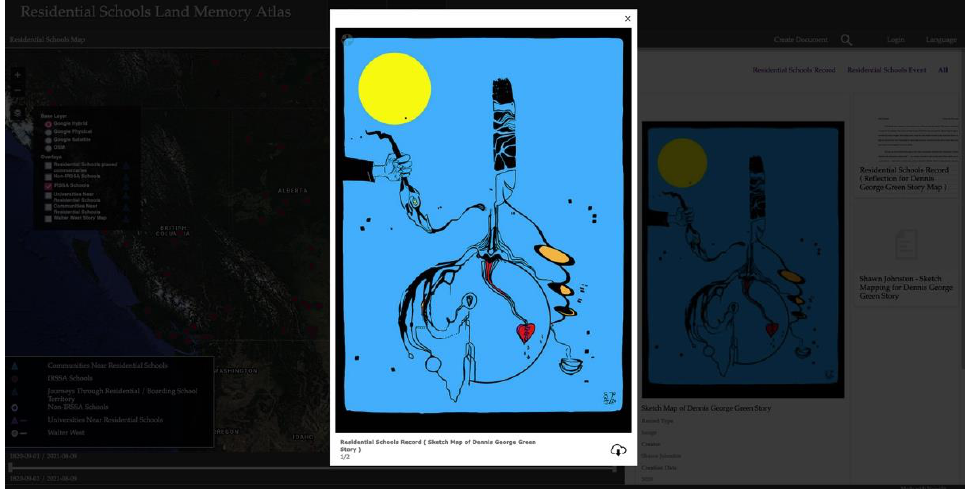
Figure 7. Screenshot of the Residential Schools Map of the Residential Schools Land Memory Atlas, showing a full view of Shawn Johnston ’s sketch mapping for the story of Dennis George Greene.